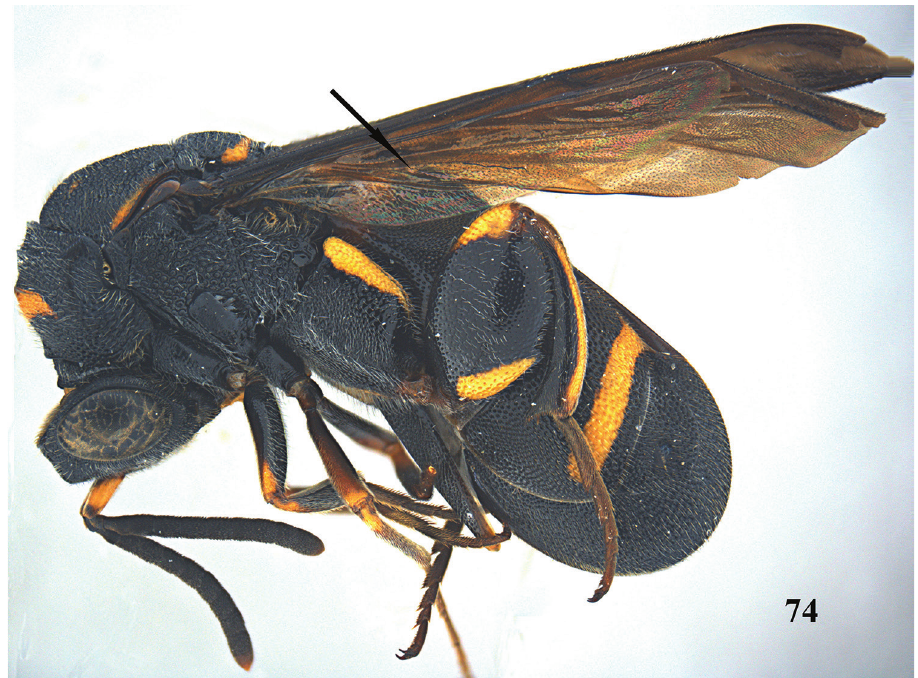
Figure 74. Leucospis shaanxiensis sp. n., ♀ , holotype, habitus lateral. coxa with yellow stripe dorsally (Fig. 82), hind femur with yellow mark ventro-basally, and similar yellow mark apico-dorsally (Fig. 83), hind tibia mostly yellow dorsally, T1 with a pair of yellowish spots antero-dorsally, T4 with yellow stripe near anterior mar- gin, T5 with yellow stripe near posterior margin (Figs 74, 78); pronotum with distinct discal carina and premarginal carina, first one arcuate, latter one straight; dorsellum without carinae, rounded posteriorly (Fig. 78); hind femur with fourteen teeth ventral- ly, forming a rather irregular row (Figs 74, 83); concavity below apical spine of hind tibia with slender spines and long setae (Fig. 83); T1 angularly protruding dorsally with ovipositorial furrow on top of it and laterally distinct smooth interspaces between coarse punctures (Fig. 78); ovipositorial furrow on T1 deep, single, and distinctly im- pressed on T4 (Fig. 78); T5 0.7 times dorsal length of T1 (Fig. 78); ovipositor sheath long, nearly reaching anterior margin of T1 (Fig. 78). 3.0 POD; MS = 1.9